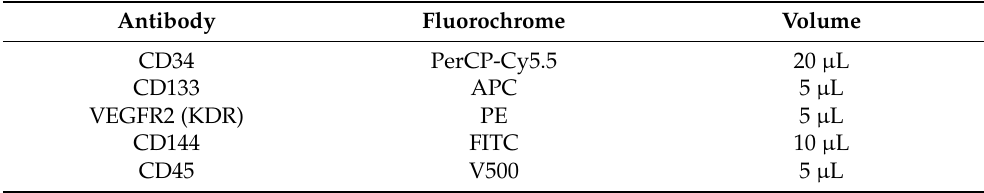
Table 1. Antibodies used for enumeration of cEPCs and progenitor cells.